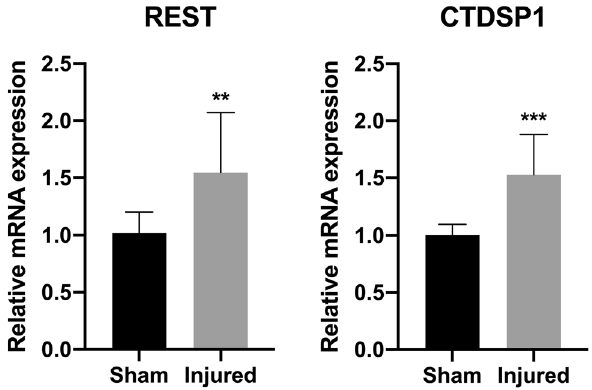
Figure 4. REST and CTDSP1 are upregulated after peripheral nerve injury. qRT-PCR analysis of mRNA expression levels in L3-L5 DRGs dissected 24 h after sciatic nerve injury or sham surgery. ** p < 0.01, *** p < 0.001, Mann–Whitney test, n = 10 DRGs from three rats for sham, n = 7 DRGs from three rats for injured, error bars are